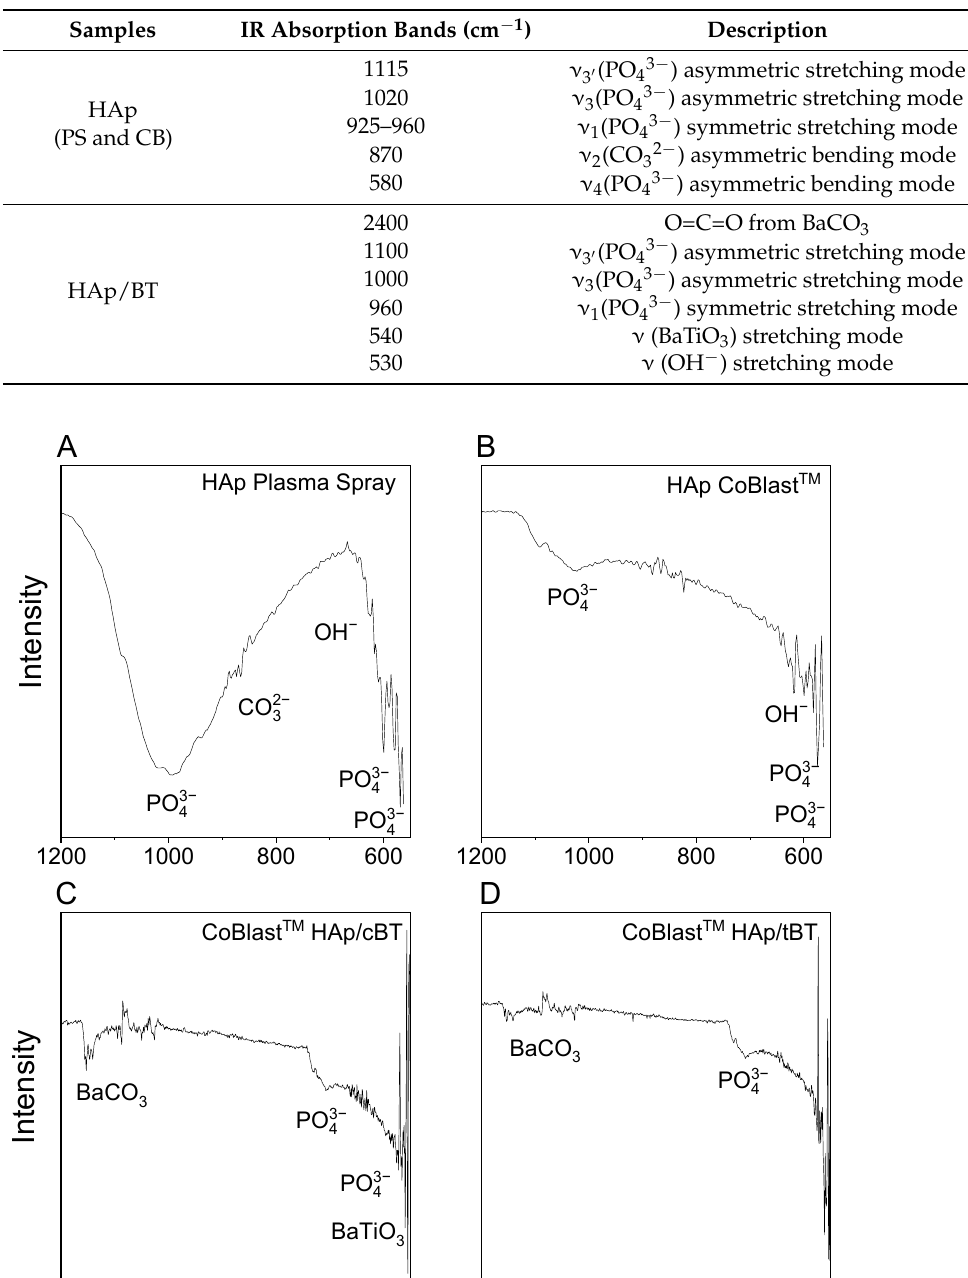
Table 4. Assignment of FTIR spectra of HAp by PS and HAp, HAp/cBT and HAp/tBT by CB coatings